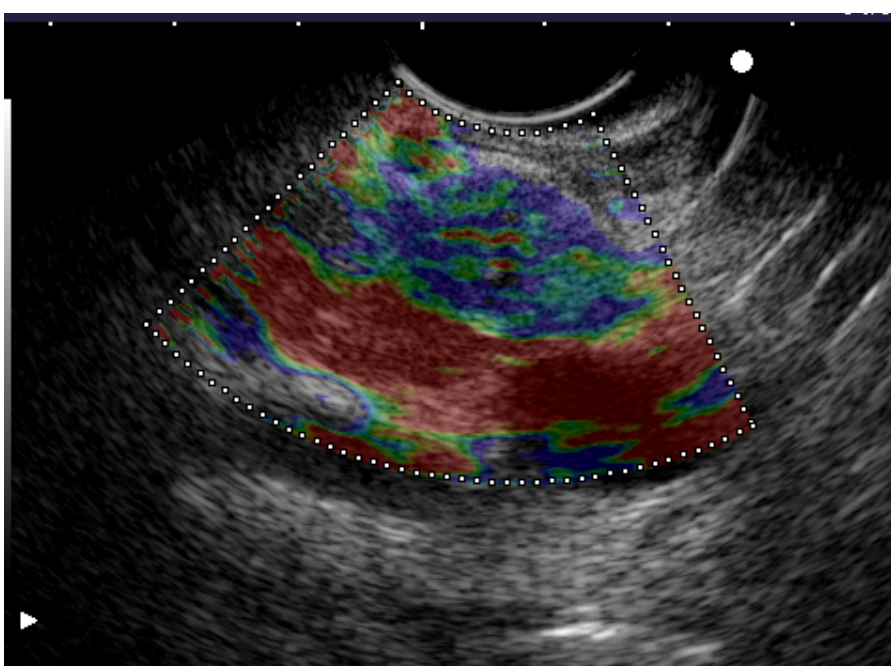
FIGURE 15 . Score 5: pancreatic adenocarcinoma developed on chronic